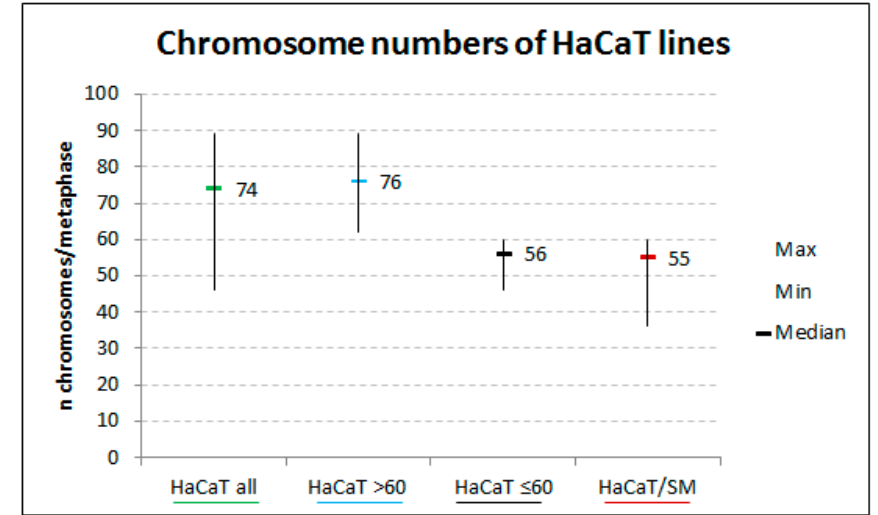
Figure 2. Survival of HaCaT after irradiation. Cellular survival after increasing doses of X-ray Figure 1. Chromosome numbers in HaCaT/sulfur mustard (SM) and HaCaT. HaCaT parents (all)